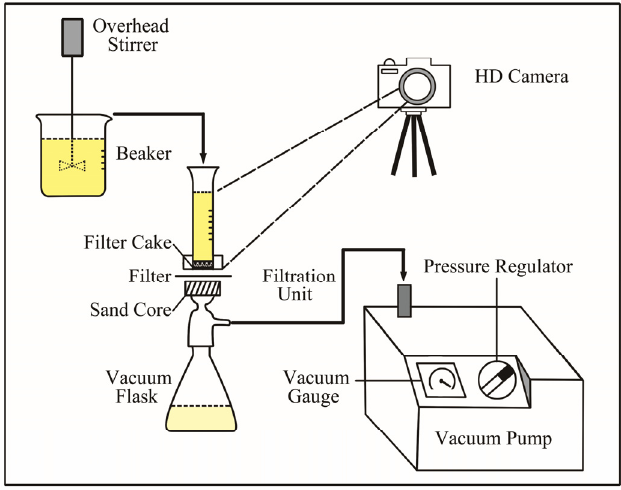
Figure 4. A schematic diagram of the experimental filtration devices.